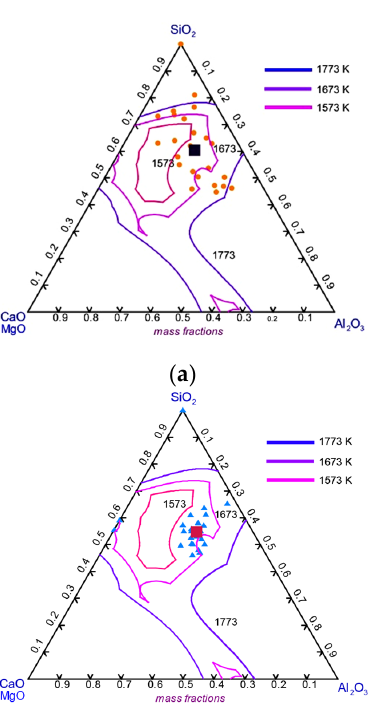
Figure 6. Inclusion distribution overlaid on a phase diagram with the refining slags at fixed Al 2 O 3 contents of ( a ) 3 wt.%, ( b ) 5 wt.%, ( c ) 8 wt.% and ( d ) 12 wt.%.